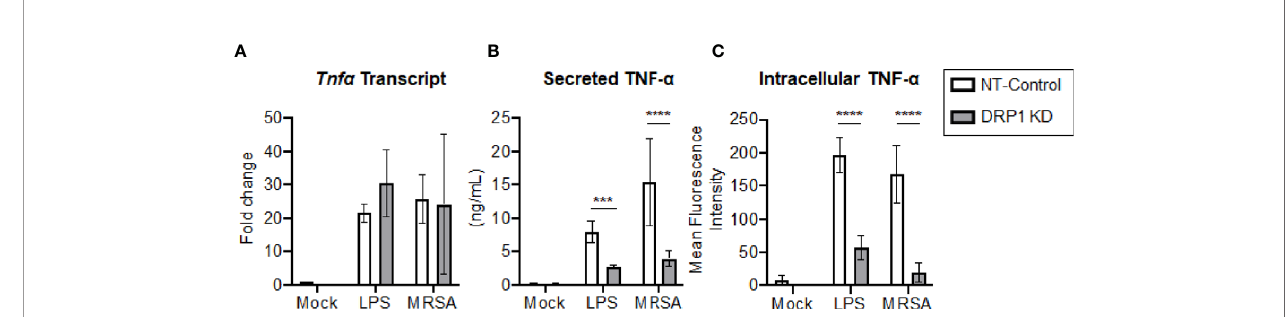
FIGURE 4 | DRP1 regulates TNF- a production at post-transcriptional level. (A) Quantitative real-time PCR of Tnfa transcript levels of NT-Control and DRP1 KD macrophages after 4h stimulation with LPS or MRSA infection (MOI 20). Data are relative to NT-Control macrophage untreated (Mock) condition. (B) TNF- a levels in culture media of conditions from (A) were quanti fi ed by ELISA at 24h post-stimulation. (C) Total TNF- a levels were monitored by intracellular staining using fl ow cytometry after blocking protein transport with monensin. Macrophages were stimulated with LPS (200 ng/ml), infected with MRSA (MOI 20) or left untreated (Mock) in the presence of monensin 4h and stained intracellularly for TNF- a . Mean fl uorescence intensity (MFI) of TNF- a was determined using FlowJo software, representing the geometric mean. Graphs show the mean ± SD from at least three independent experiments. P value was calculated using two-way ANOVA with Sidak ’ s post-test for multiple comparisons. *** P < 0.001; **** P